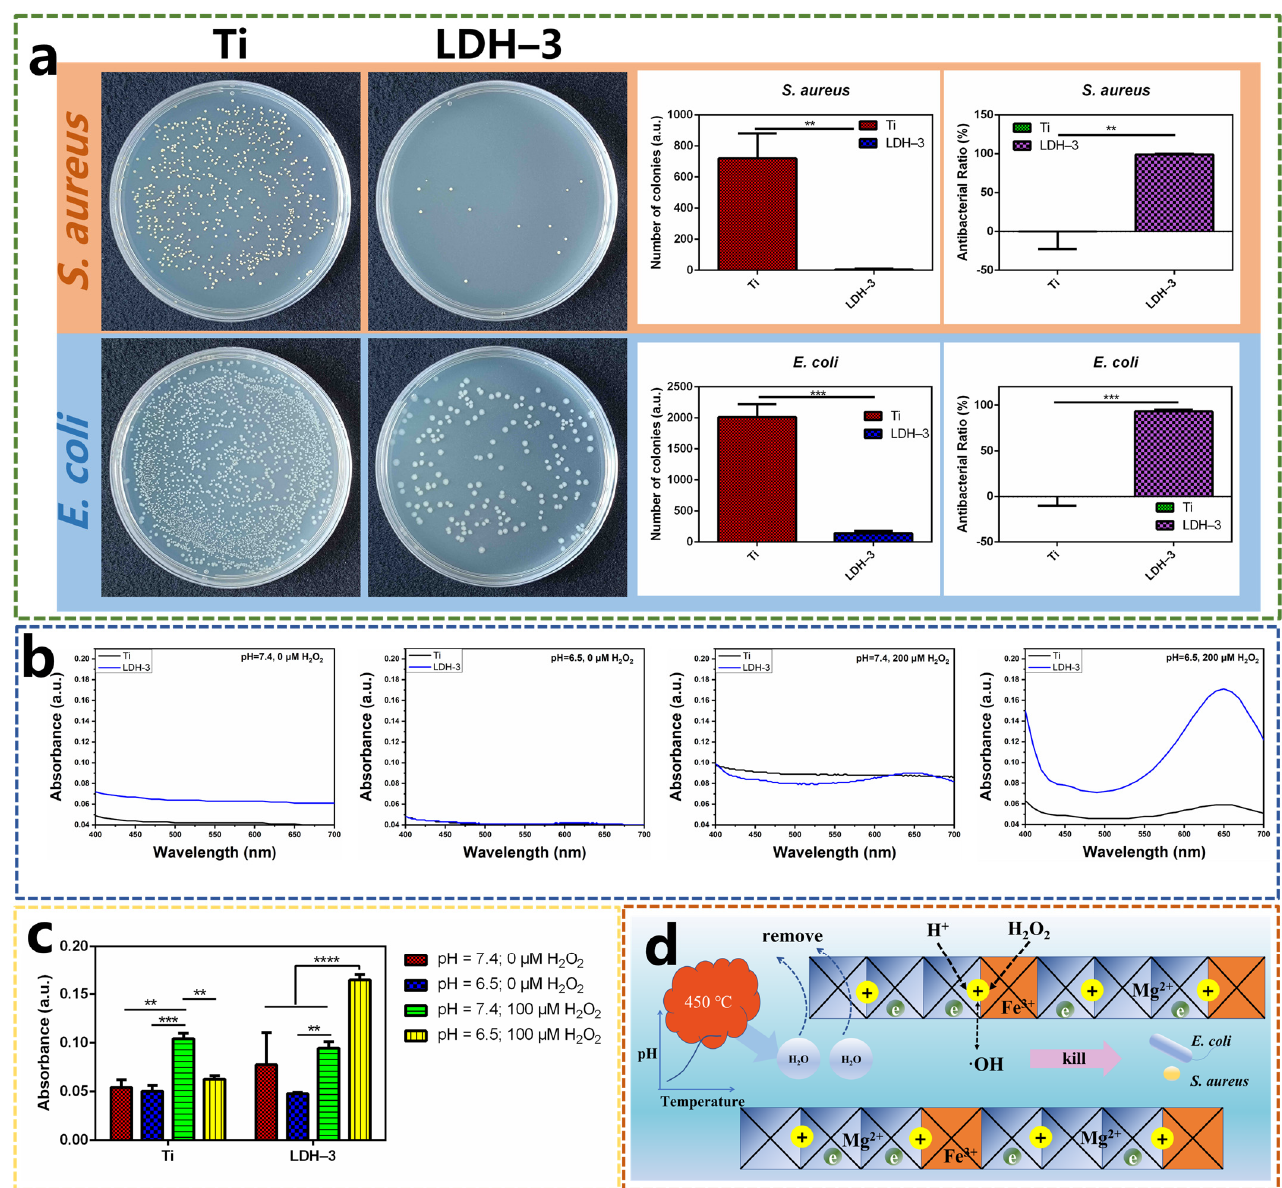
Figure 3. ( a ) Photographs of colony distributions of S. aureus and E. coli cultured on Ti and LDH − 3 samples under an acidic microenvironment containing 200 μ M H 2 O 2 and corresponding quantitative analysis; ( b )·OH detection concentrations of Ti and LDH − 3 under di ff erent conditions; ( c ) quantitative analysis; ( d ) schematic diagram of the antimicrobial mechanism in a simulated bacterial microenvironment containing H + and H 2 O 2 of the LDH − 3 sample. (** p < 0.01, *** p < 0.001, **** p < 0.0001)